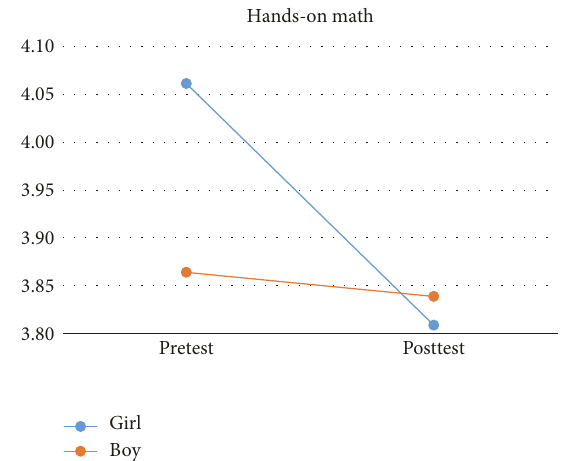
Figure 2: By hands-on I learn effectively , pre- and posttest plots by